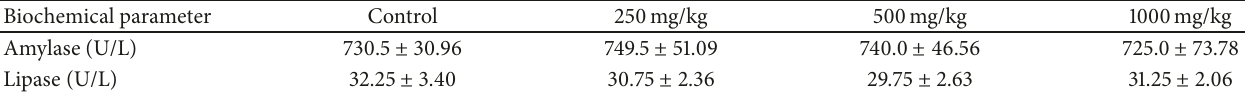
Results are expressed as mean ± SD (n=8). No significant changes were found when all treatment groups compared against control group (p < 0.05) as determined by using a one-way ANOVA followed by Dunnett’s multiple comparison tests.